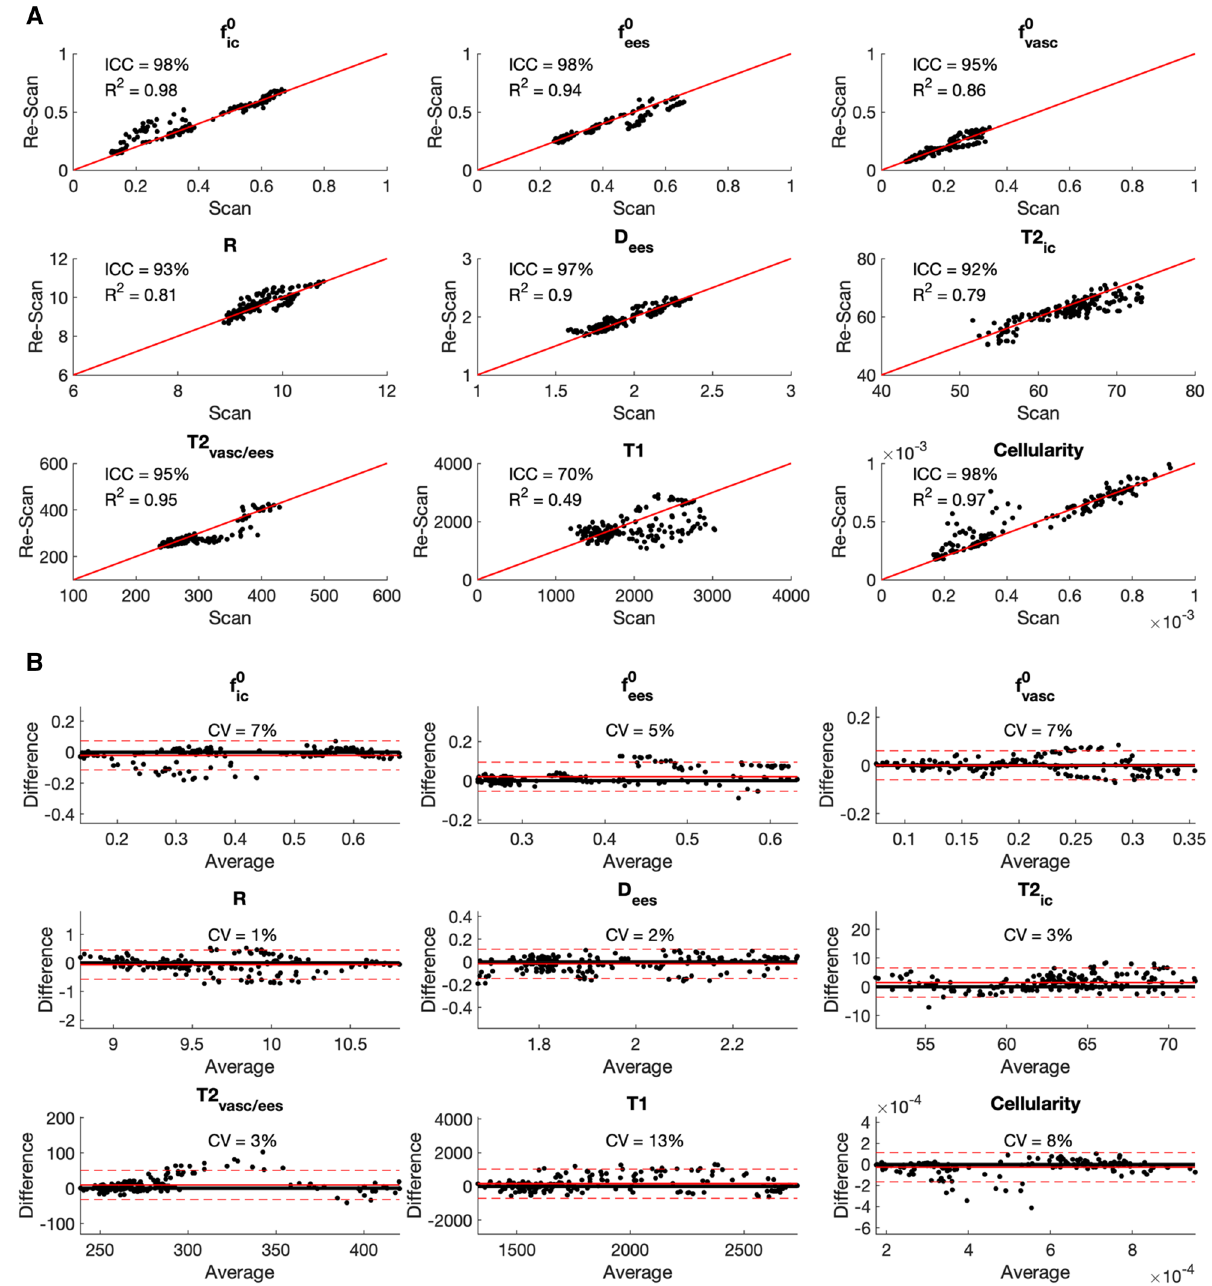
Figure 4. Repeatability of the rVERDICT parameters. ( A ) Correlation plots for all the rVERDICT parameters in the scan/rescan study. The corresponding R 2 and ICC are reported for each of them, together with the identity line. ( B ) Bland–Altman plots of the scan/rescan estimates for all the rVERDICT parameters. The corresponding CV is reported for each of them, together with the average (straight red line) ± 1.96 standard deviation (dashed red lines) of the difference. The dimensional parameters are in μm (apparent cell radius R); μm −3 (Cellularity); μm 2 /ms (extracellular-extravascular apparent diffusivity Dees) and ms (T1, intracellular T2 ic and vascular/ extracellular-extravascular T2 vasc/ees